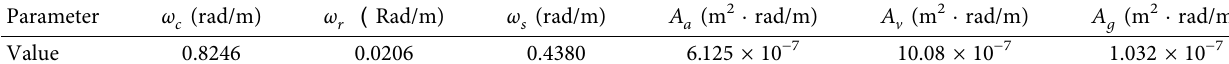
Table 4: The parameters of track irregularity PSD.